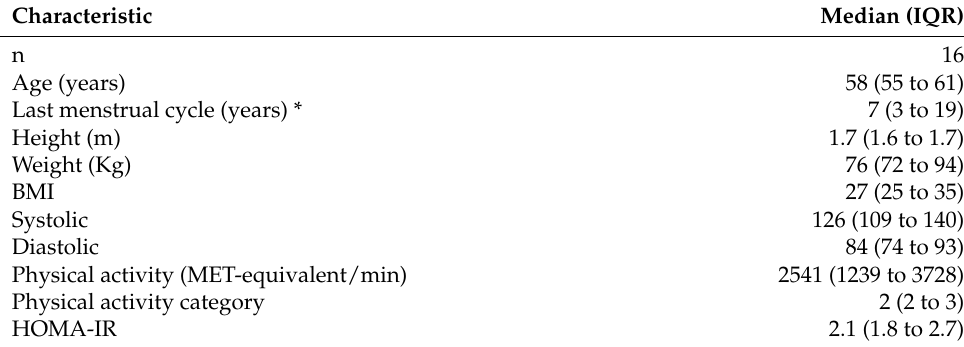
Table 3. Baseline characteristics of the study participants. Data represented as median and interquar- tile